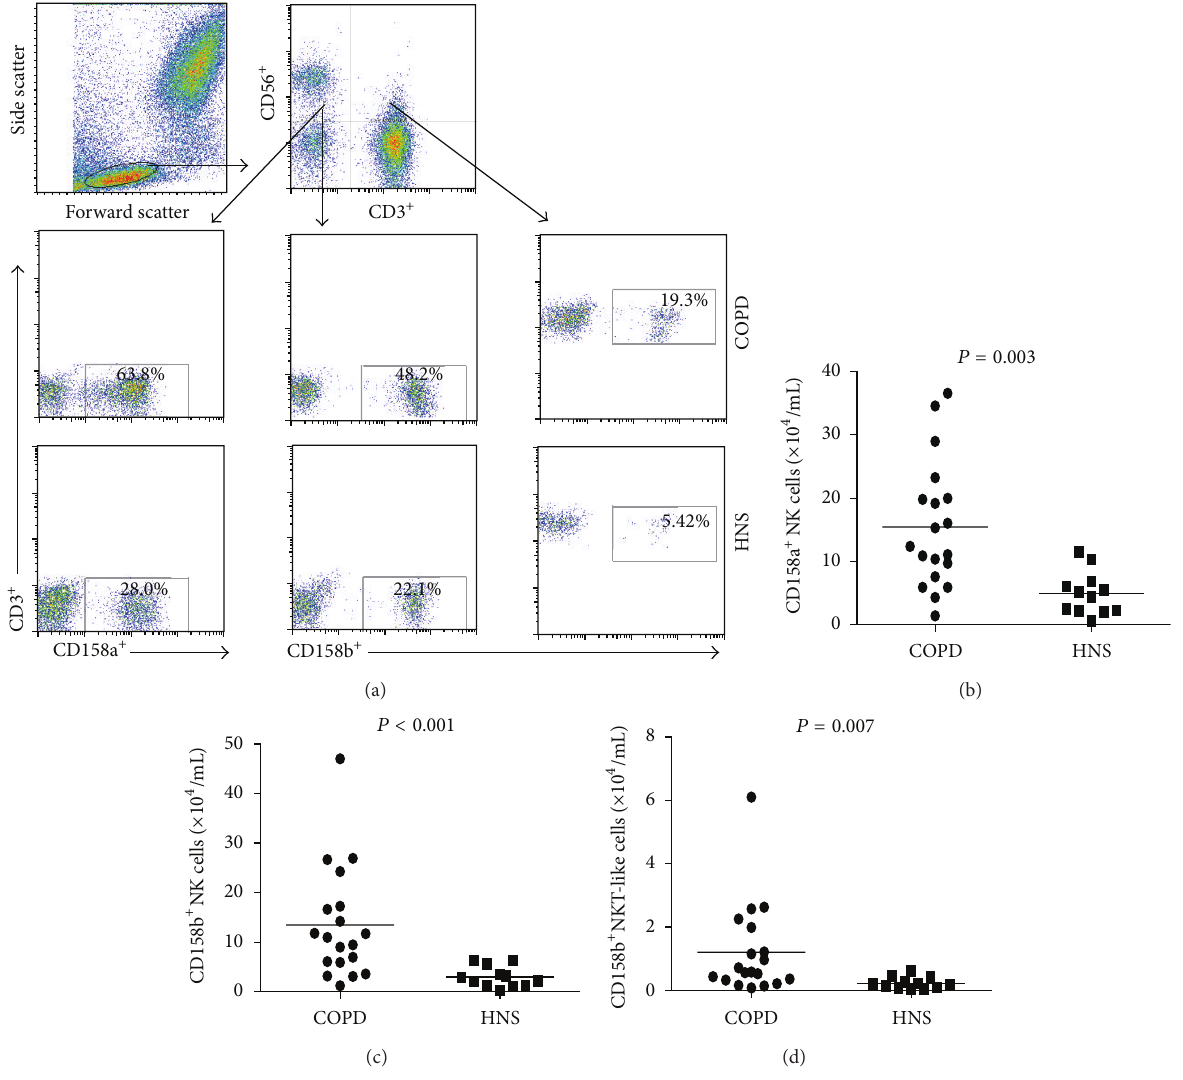
Figure 3: CD158a + NK cells, CD158b + NK cells, and CD158b + NKT-like cells in COPD patients. (a) Data shown are representative charts from different groups of subjects and the frequencies of CD158a + , CD158b + NK cells, and CD158b + NKT-like cells in individual subjects. (b) Summarized data show the number of CD158a + NK cells in COPD patients and HNS. The horizontal lines show the median. (c) Summarized data show the number of CD158b + NK cells in COPD patients and HNS. (d) Summarized data show the number of CD158b + NKT-like cells in COPD patients and